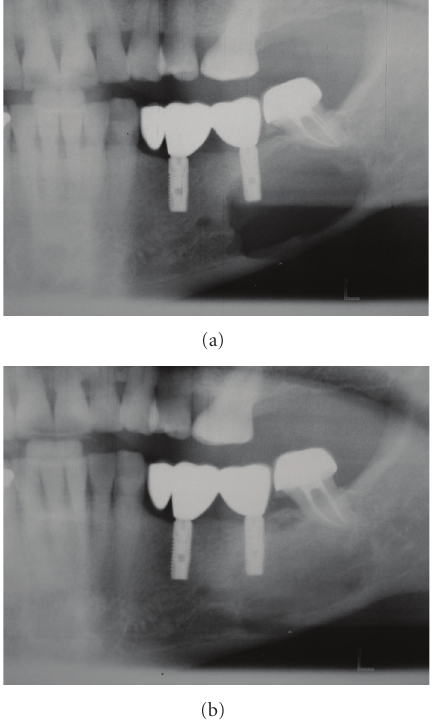
Figure 2: (a) Panoramic radiograph showed a large lytic lesion adjacent to the left implant and second left mandibular molar, diagnosed as MM (March 2007). (b) A new panoramic radiograph performed seven months after starting therapy revealed a complete regression of the mandibular lesion, supporting previous diagnosis of mandibular involvement of MM.